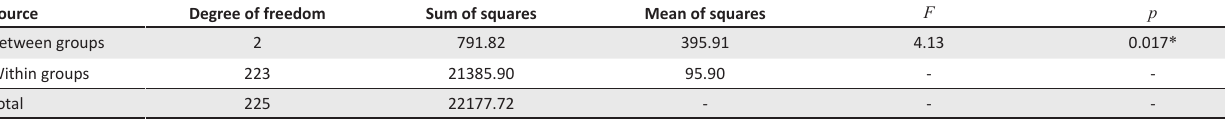
TABLE 6: One-way analysis of variance of validated Attitudes Toward Suicide Scale scores in levels of perceived competence. Source Degree of freedom Between groups Within groups